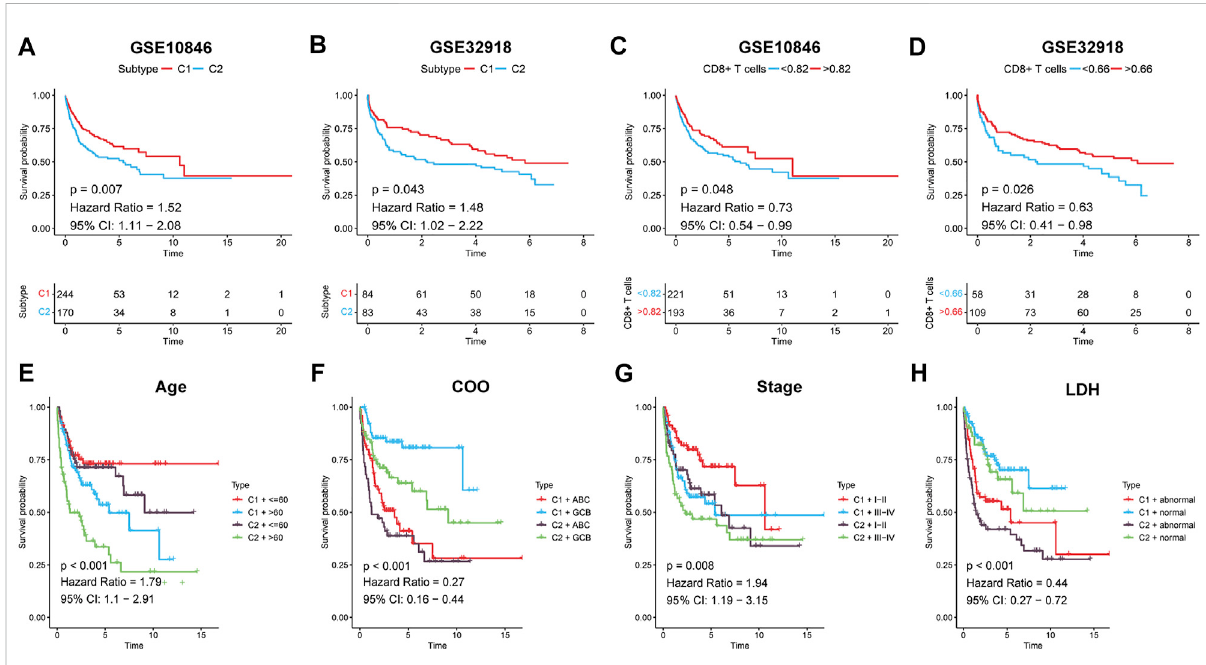
FIGURE 5 Survival analysis for DLBCL patients. (A,B) Kaplan-Meier survival curves for the two subtypes. (C,D) Kaplan-Meier survival curves for high/low CD8 + Tcellsgroups.Kaplan-MeiersurvivalcurvesforDLBCLpatientsbothbythetwosubtypesand (E) Age, (F) COO, (G) Stage, (H) LDH,respectively. P < 0.05 was considered signi fi